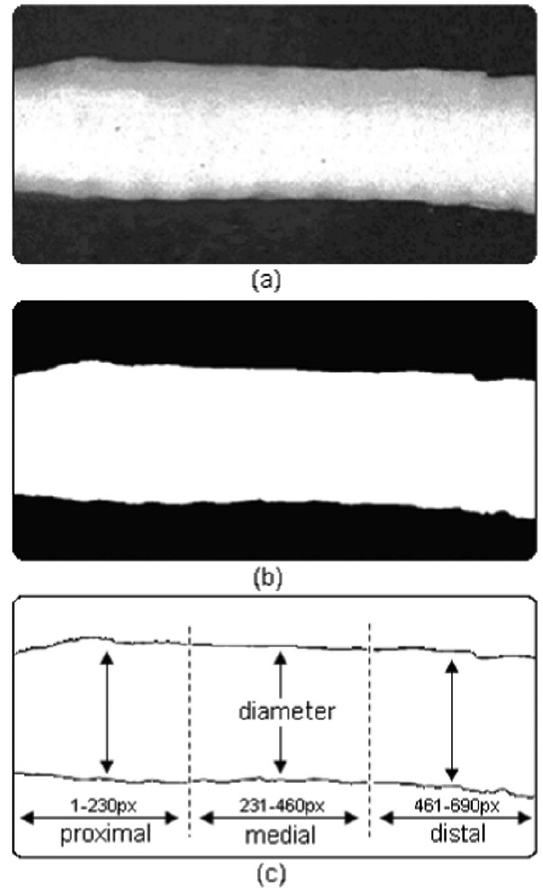
Figure 2 - A trachea from the CONTROL group. (a) Normal image. (b) Segmented image. (c) Division of the areas of analysis.